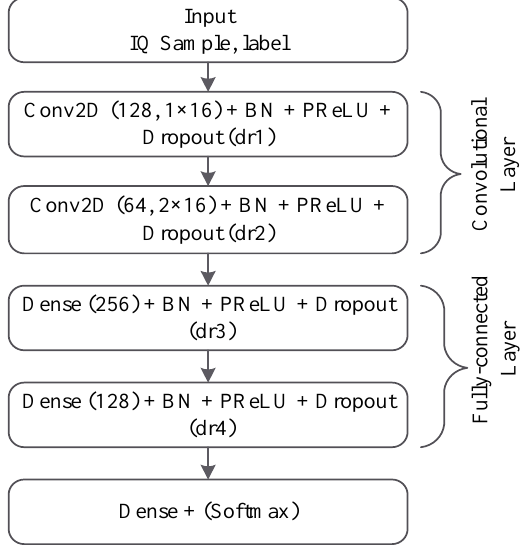
Figure 6. Framework of the proposed CNN-based MC system [85].